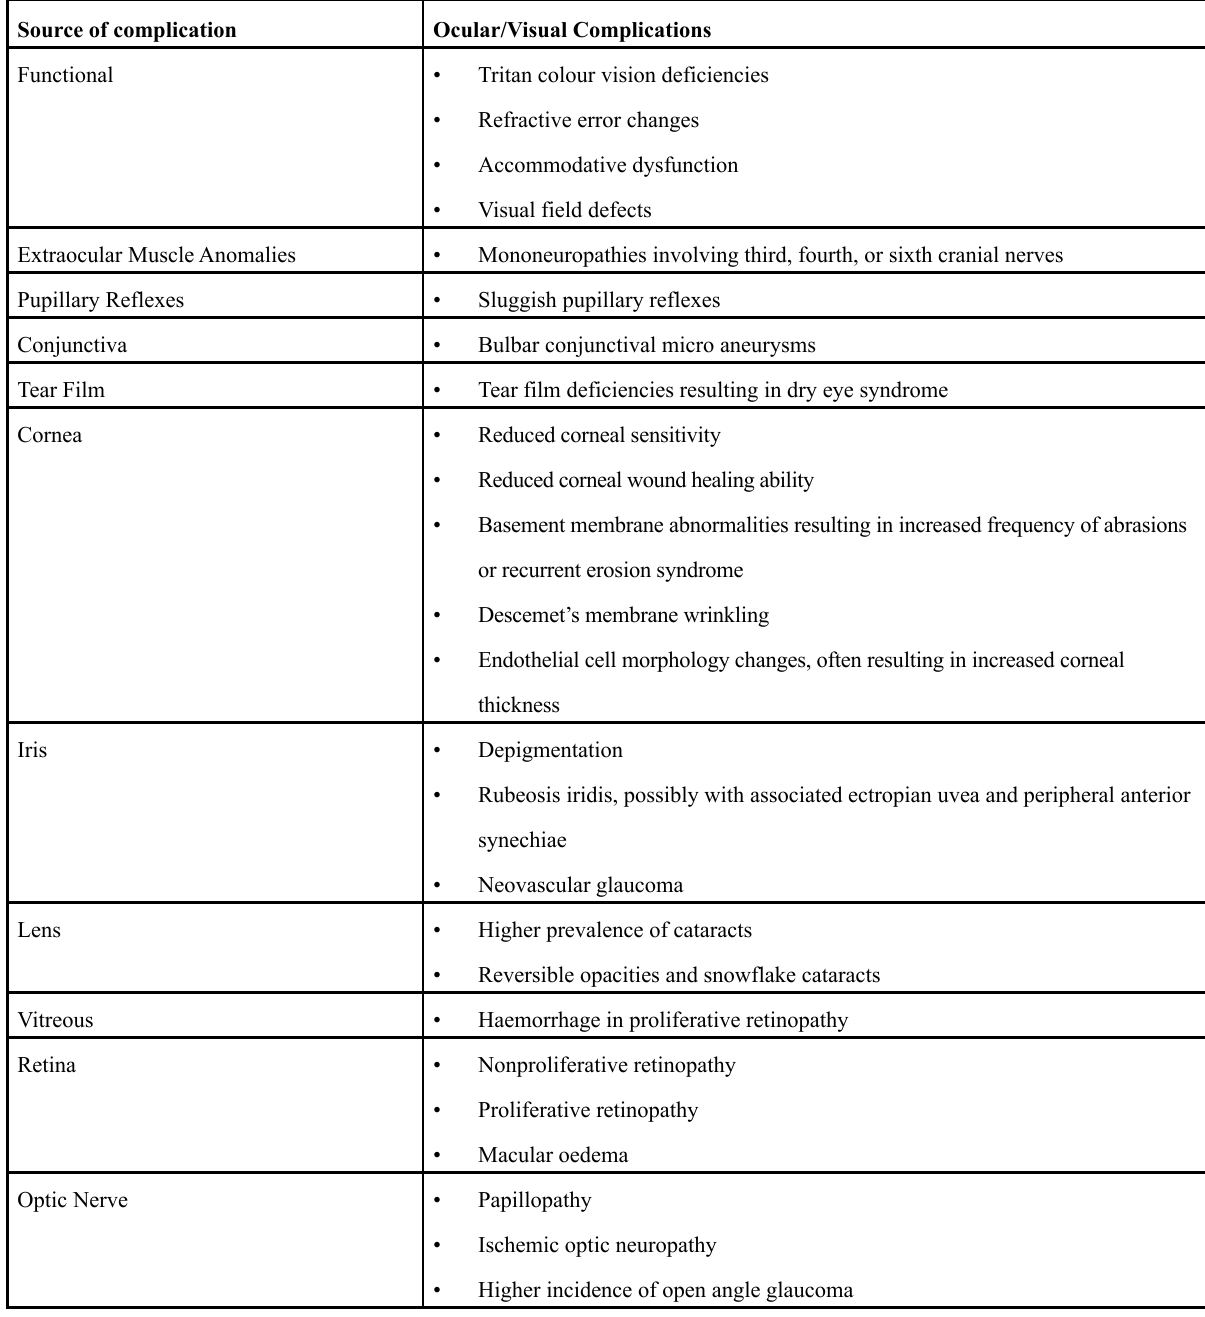
Table 1 : Ocular and visual complications of Diabetes Mellitus 21